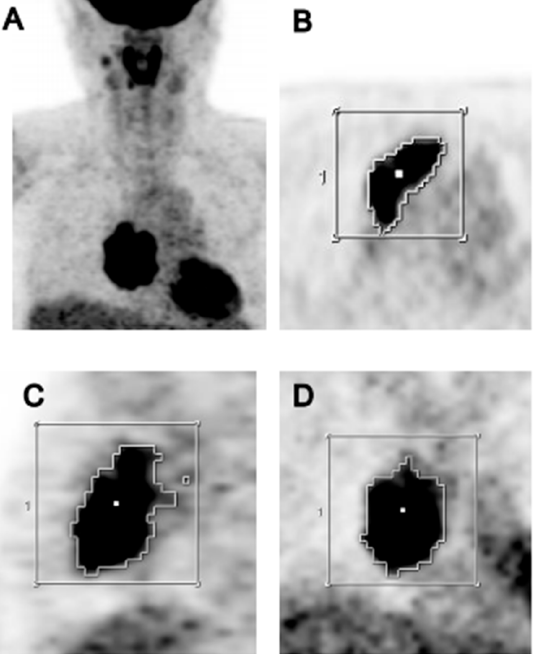
Figure 1. 18 F-fluorodeoxyglucose positron emission tomography/computed tomography ( 18 F-FDG PET/CT) images of a 54-year-old female patient with thymoma type B1. ( A ) The high FDG uptake by the primary mediastinal tumor is clearly visible in the maximum intensity projection image. A volume of interest (VOI) was semi-automatically placed over the tumor using an isocontour threshold of SUV 2.5. The segmented VOI is shown on the transverse ( B ), sagittal ( C ), and coronal ( D ) images.